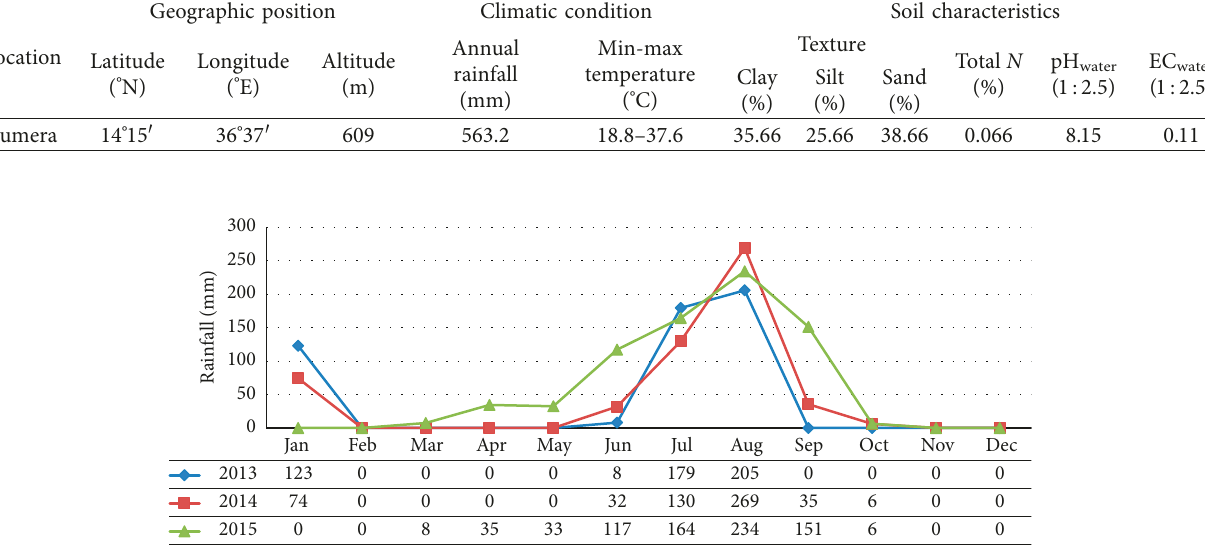
Figure 2: Monthly rainfall (mm) of the growing area during the three cropping Table 2: Genotypic code, status, and source of the evaluated sesame genotypes. Genotype